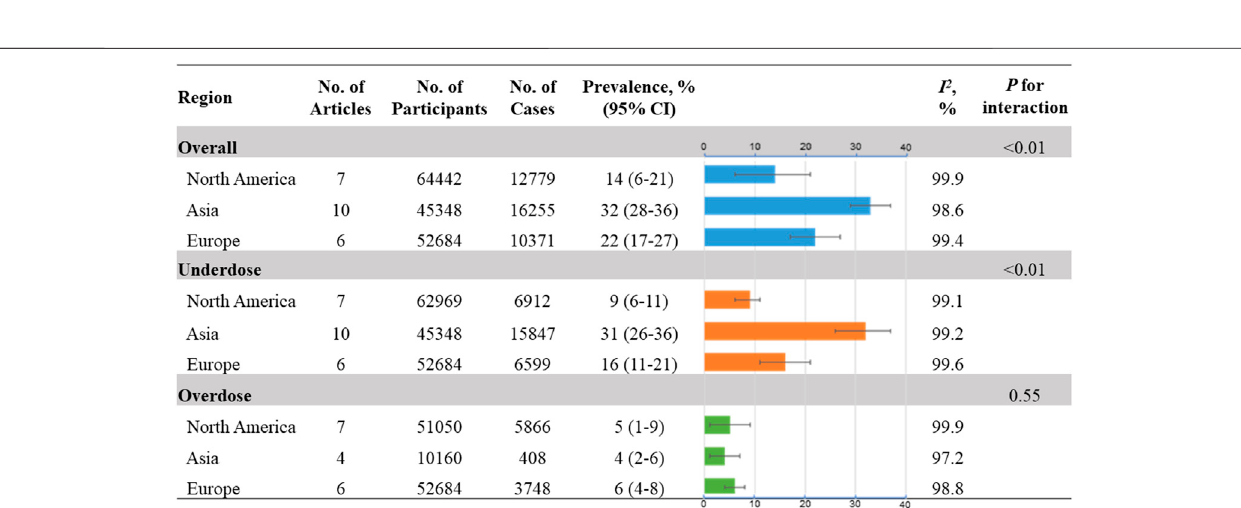
FIGURE 3 | Prevalence of DOAC off-label doses by regions No.: number of included studies.